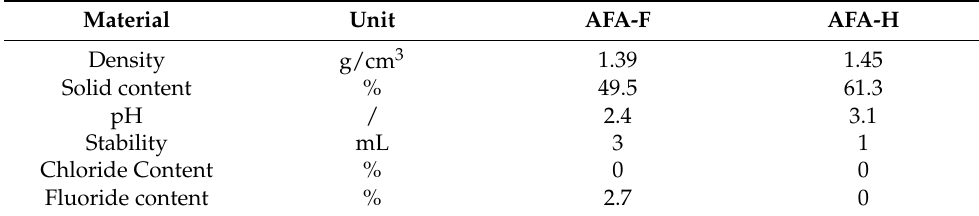
Table 2. Physical properties and chemical compositions of